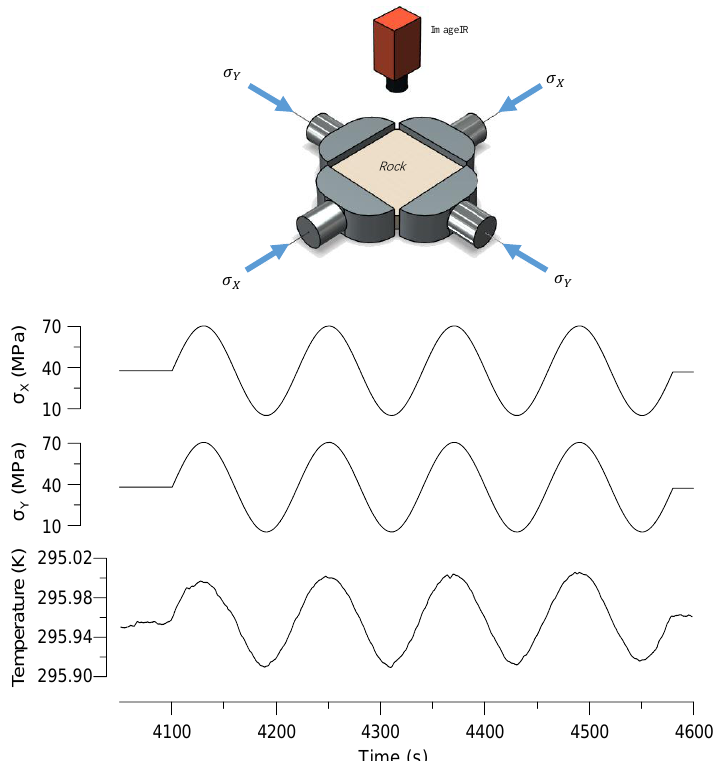
Figure 2. Variation in temperature during the biaxial test with in-phase loading on granite diorite.